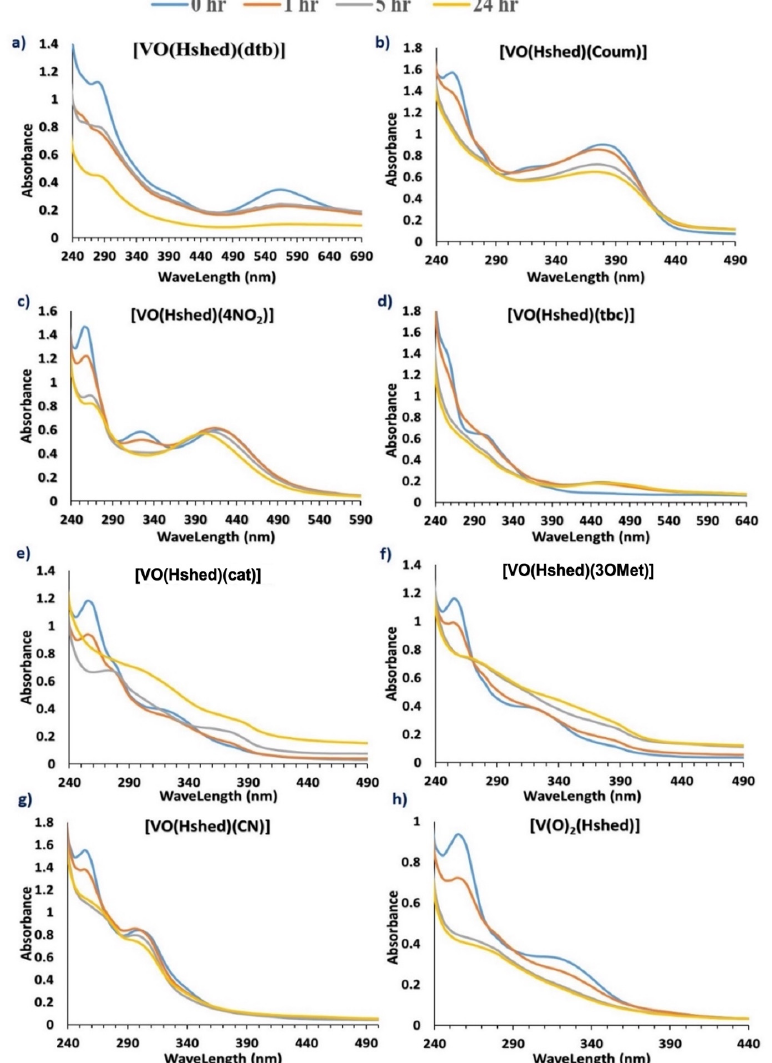
Figure 4. UV-Vis spectra for all of the complexes at 0.250 mM in 7H9:DMSO as a function of time (0, 1, 5, 24 h).The compounds from which the spectra ( a – g ) are listed above each of the